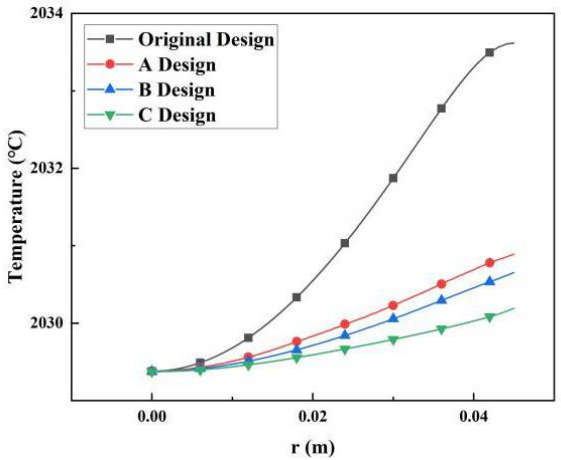
Figure 3. Radial temperature distributions of the AlN seed surface in different types of crucibles.